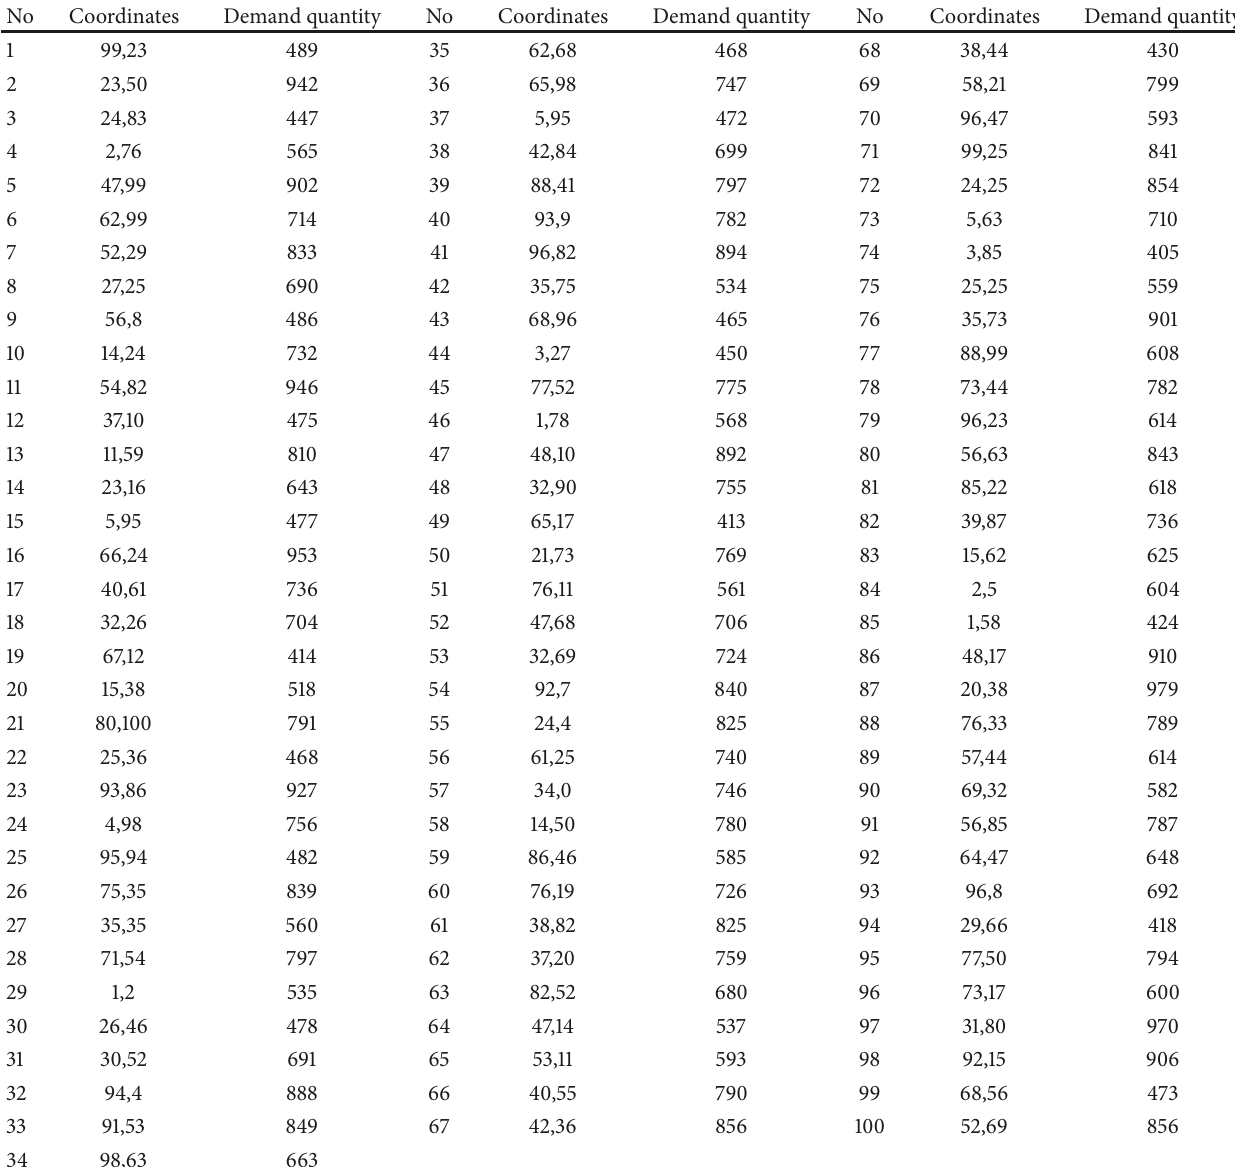
Table 6: Coordinates and demand quantity of demand point.